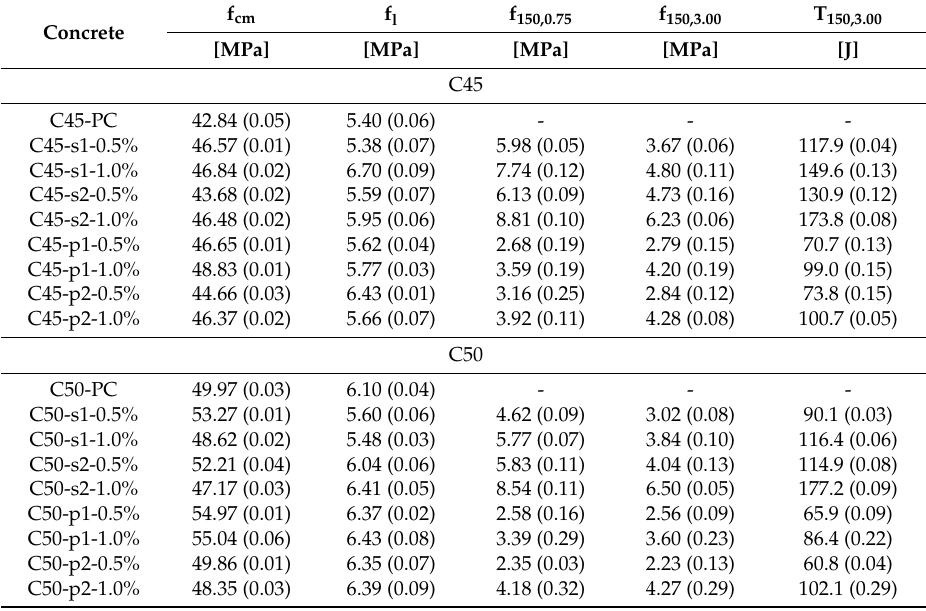
Table 6. Compressive strength (f cm ), flexural tensile strength (f l ), residual flexural strengths (f 150,0.75 and f 150,3.00 ) and toughness (T 150,3.00 ) evaluated according to ASTM